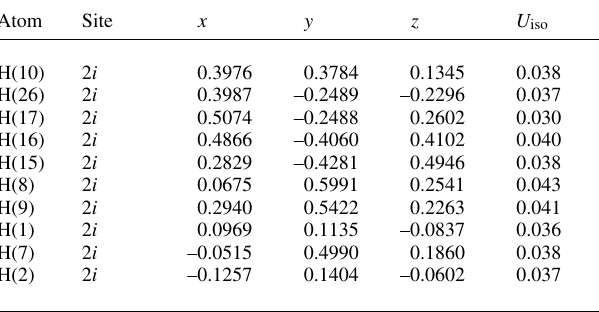
Table 2. Atomic coordinates and displacement parameters (in Å 2 )